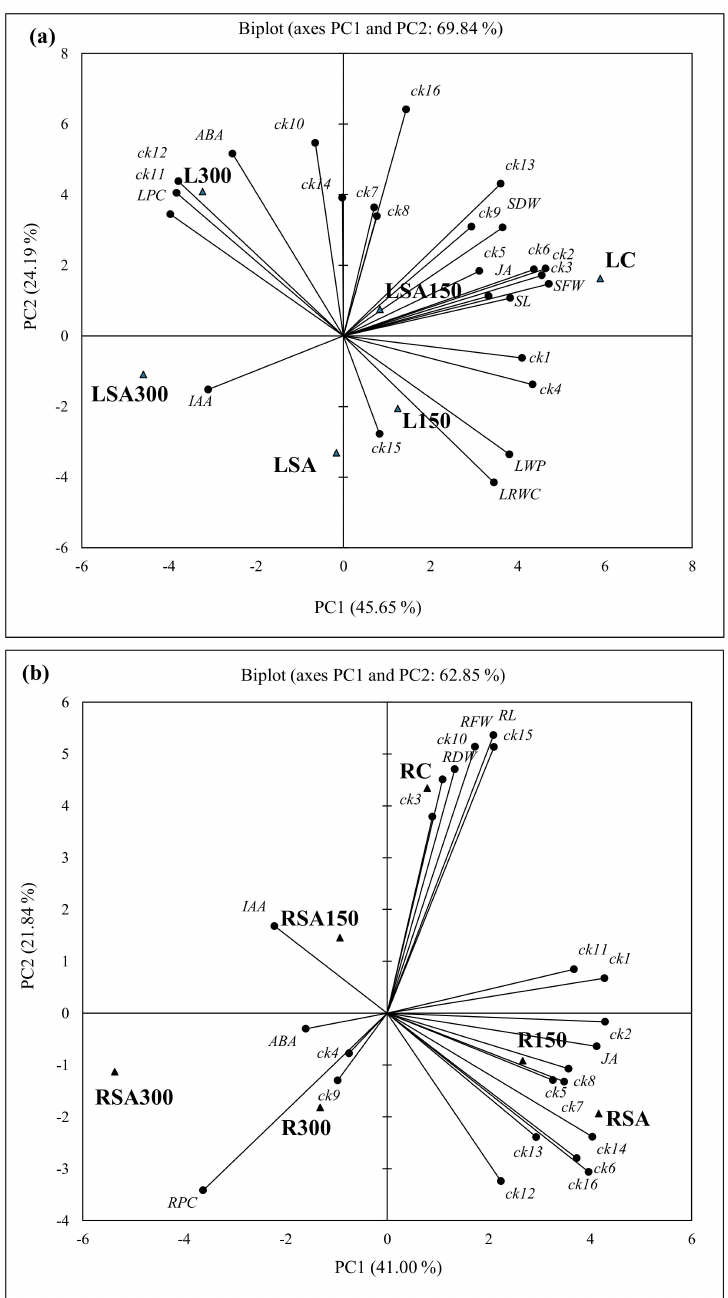
Figure 6. Bi − plot (PC1 x PC2) of scores and loadings for the PCA of all identified and quantified 15 cytokinins, IAA, ABA, and JA, and basic morphological and physiological parameters in leaves ( a ) and root ( b ) LC; leaf control, L150; leaf 150 mM NaCl, L300; leaf 300 mM NaCl, LSA; leaf 0.5 mM SA, LSA150; leaf 150 mM NaCl + 0.5 mM SA, LSA300; leaf 300 mM NaCl + 0.5 mM SA, RC; root control, R150; root 150 mM NaCl, R300; root 300 mM NaCI, RSA; root 0.5 mM SA, RSA150; root 150 mM NaCl + 0.5 mM SA, RSA300; root 300 mM NaCl + 0.5 mM SA. CKs: ck1; t Z, ck2; t ZR, ck3; t Z9G, ck4; t ZOG, ck5; t ZROG, ck6; t ZR (cid:48) 5MP, ck7; c Z, ck8; c ZR, ck9; c Z9G, ck10; c ZOG, ck11; c ZROG, ck12; c ZR (cid:48) 5MP, ck13; iP, ck14; iPR, ck15; iP9G, ck16; iZR (cid:48) 5MP. • variables and (cid:78) observations. Values in bold are different from 0 with a significance level α =